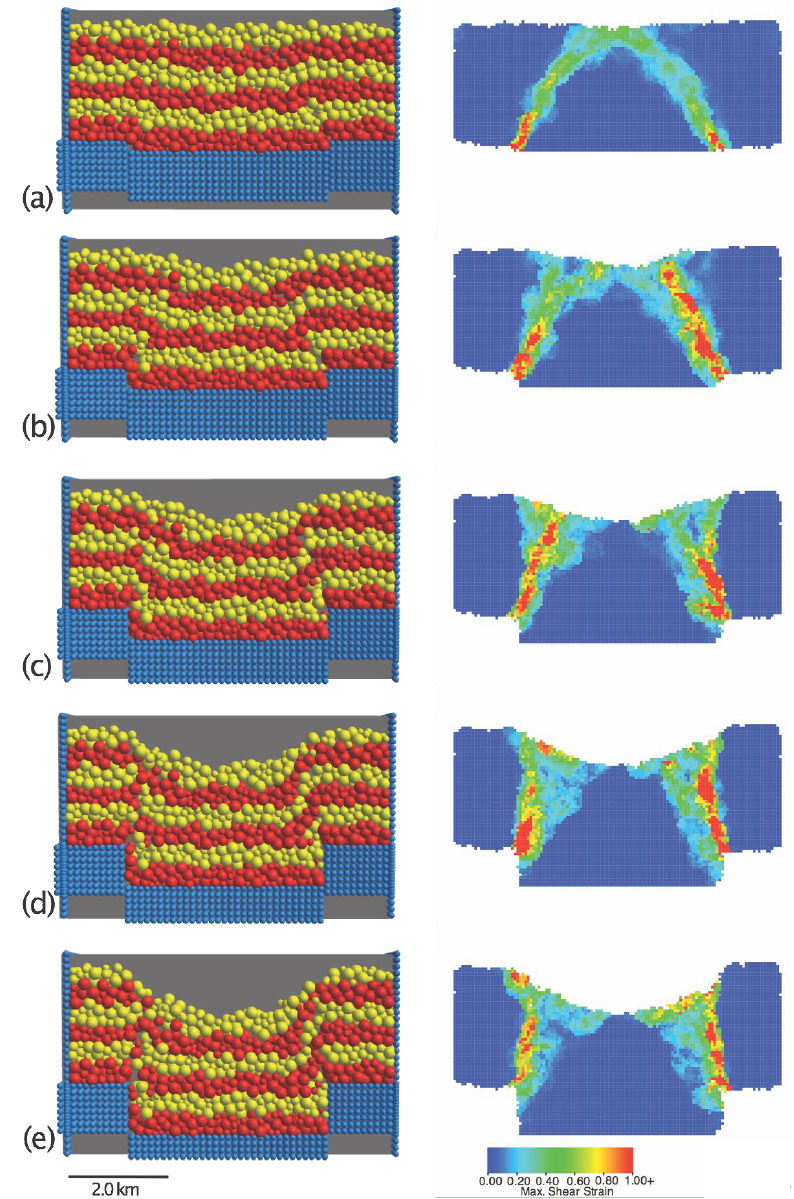
Figure 6. Evolution of vertical section B: caldera geometry (left) and incremental shear strain accrued during the preceding 200 m of basal subsidence (right) at ( a ) 200, ( b ) 400, ( c ) 600, ( d ) 800, and ( e ) 1000 m basal subsidence for an experiment with a flat, circular roof.